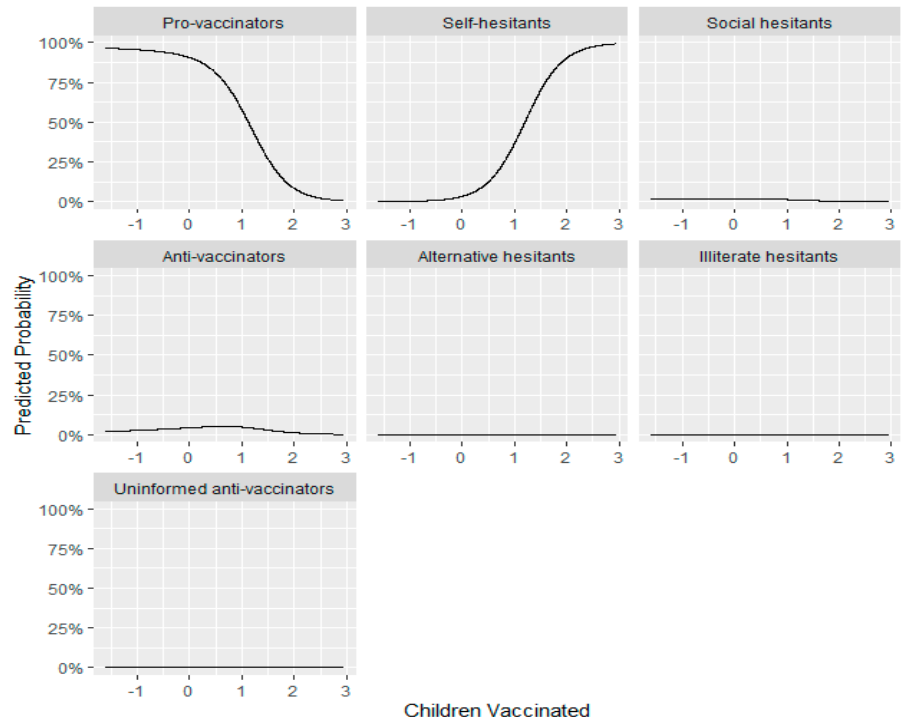
Figure A4. Marginal Effects Multinomial Logistic Regression. Children Vaccinated.